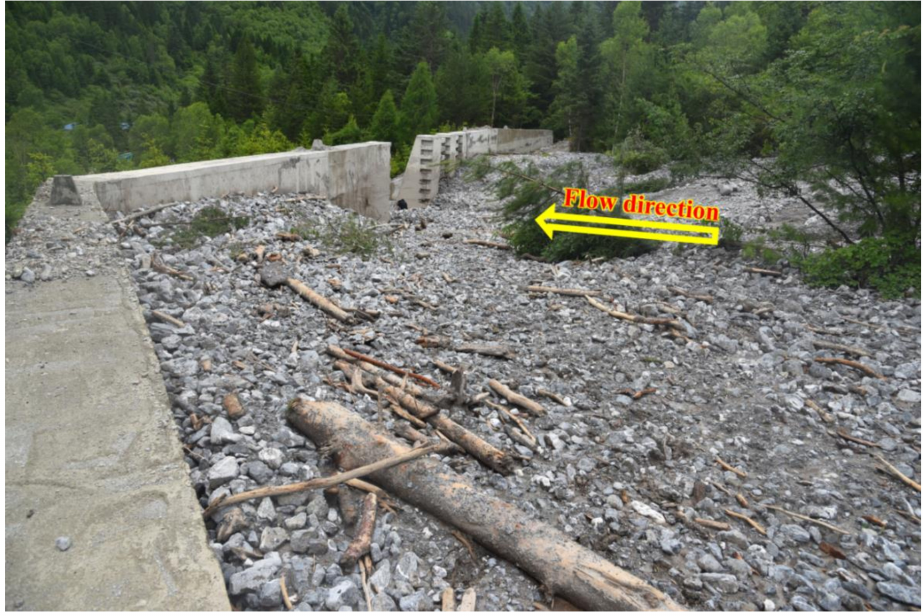
Figure 6. Overview of the reconstructed retaining wall in Zechawa Gully (taken on 23 June